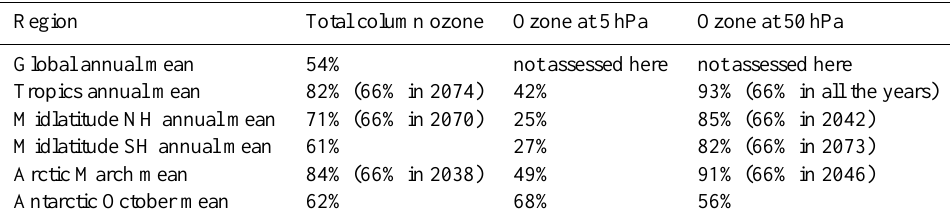
Table 5. Level of confidence that full ozone recovery has already occurred at the end of the century (2090–2097) calculated from the student t-test applied to the multi-model means of the fixed ODS simulation (fODS) and the reference simulation (REF-B2), see text for details. If the confidence level is above 66%, then the year when the confidence level reaches 66% is also added, indicating that full ozone recovery may have occurred within 1 σ